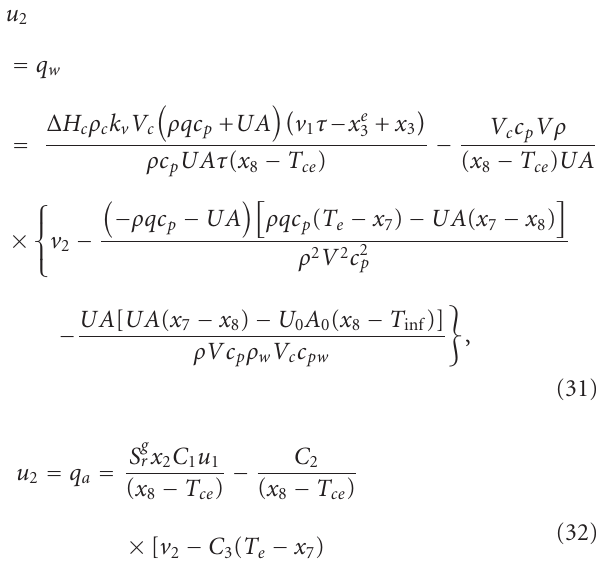
Table 3: Operating conditions and physical constants used in the